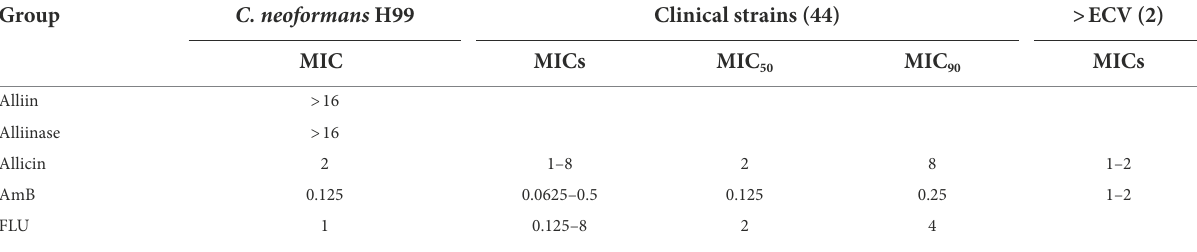
TABLE 1 Minimal inhibitory concentration (MIC)-based comparison of allicin with AmB and FLU.